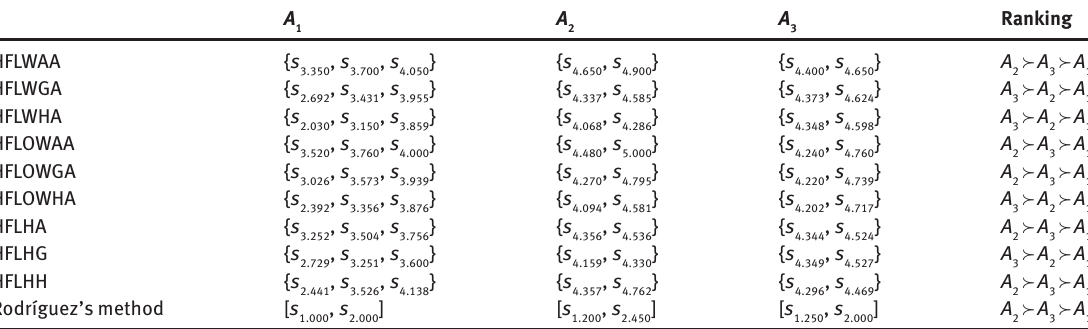
Table 9: Aggregated